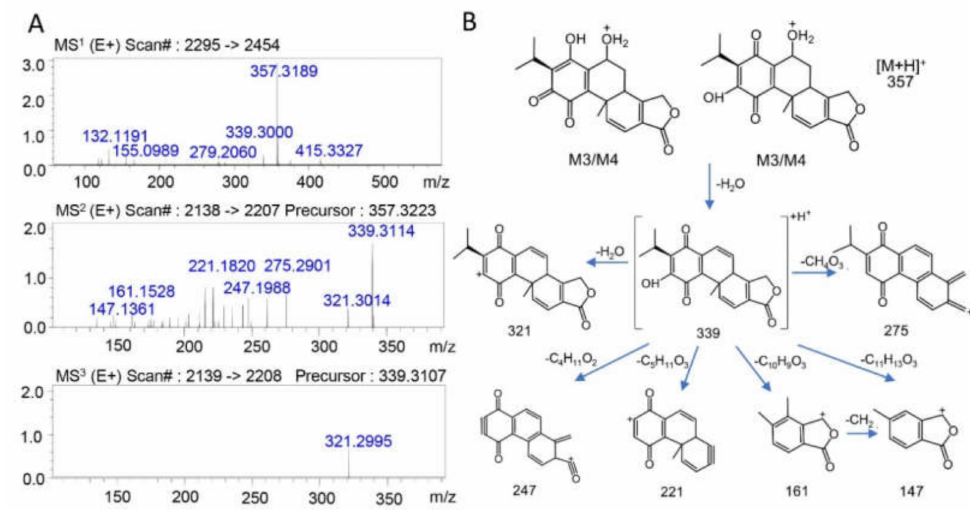
Figure 4. ( A ) The MS n data of the triptolide metabolites M3 and M4. ( B ) Possible structures and mass spectrometric cleavage pathway of the metabolites M3 and M4.